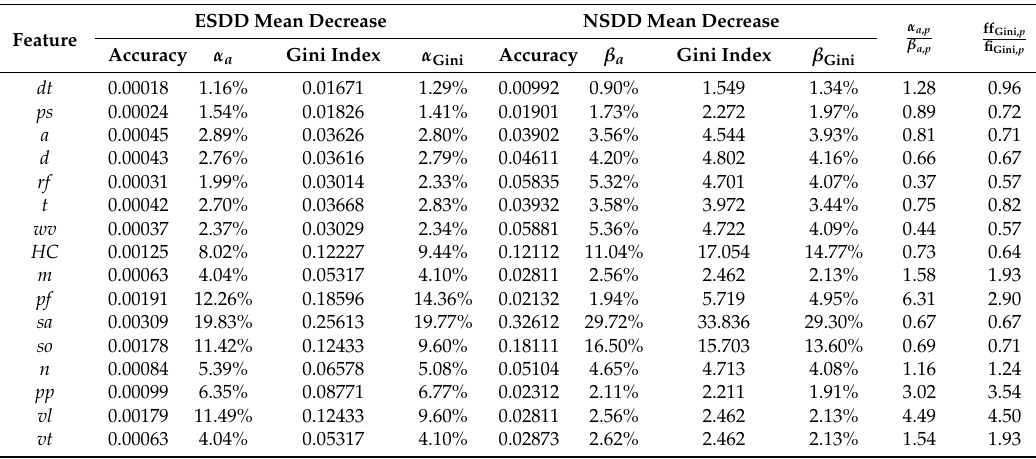
Table 5. The MDA and MDG of related factors.